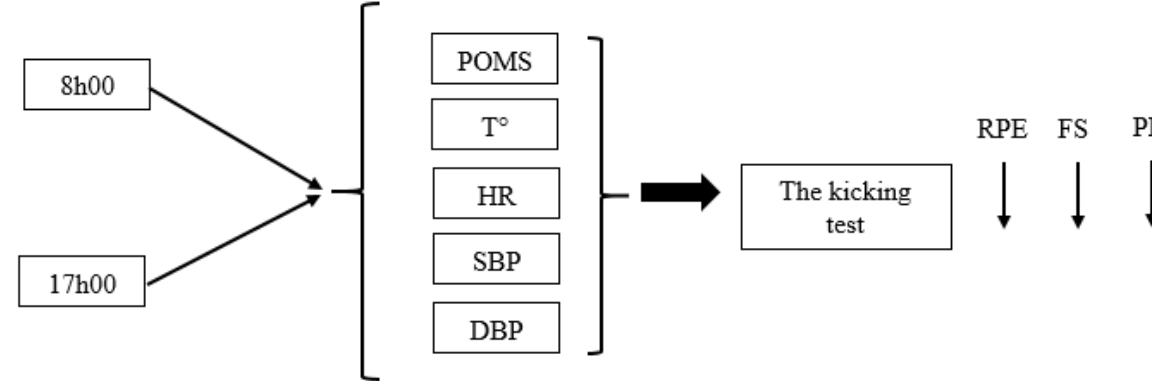
Figure 1. Schematic representation of the experimental design. POMS: Profile of mood states; T°: temperature; HR: heart rate; SBP: systolic blood pressure; DBP: diastolic blood pressure; RPE: rating of perceived exertion; FS: feeling scale; PD: perceived task difficulty.